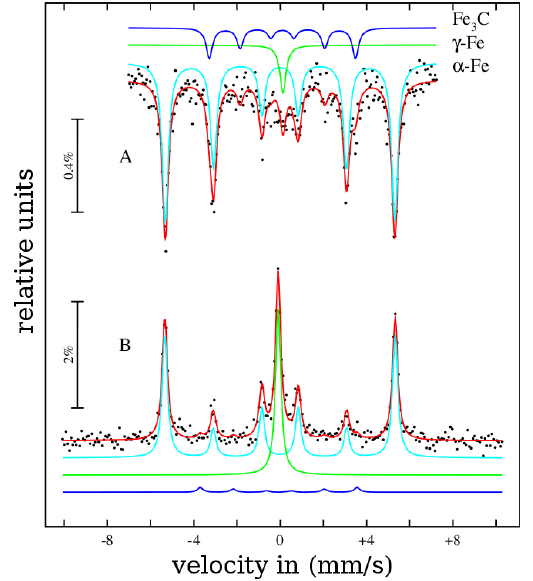
Figure 18. Typical M ¨ ossbauer spectra of aligned iron-filled CNT on a substrate. Spectra A results from TMS and spectra B from